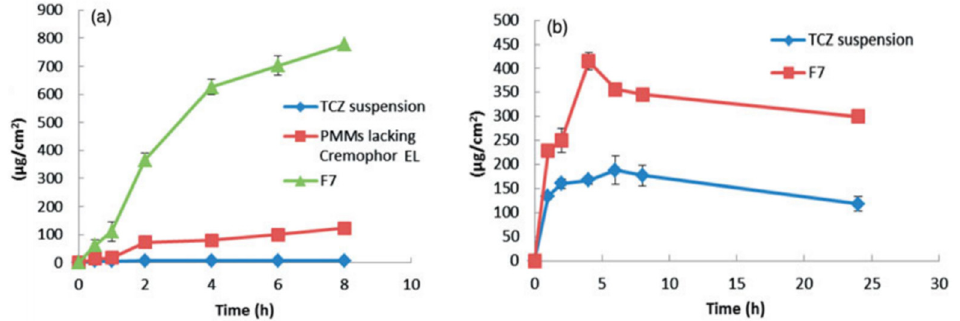
Figure 10. ( a ) Ex vivo cumulative amount of TCZ permeated per unit area across skin. ( b ) In vivo cumulative amount of TCZ deposited per unit area in the skin (adapted from [46]).